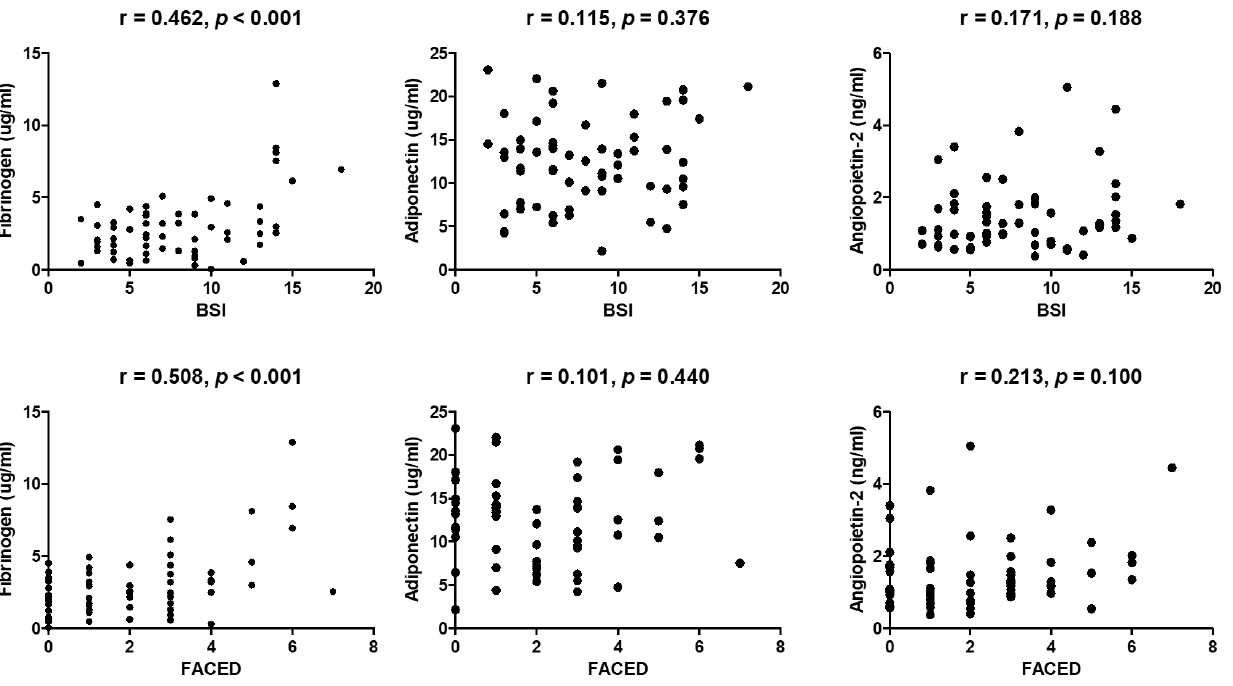
Figure 2. Correlations of fibrinogen, adiponectin, and angiopoietin-2 with BSI and FACED score. BSI: bronchiectasis severity index; FACED: FACED score.